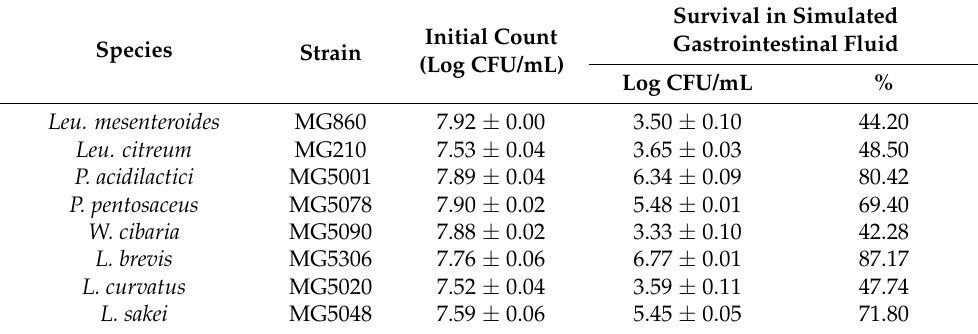
Table 2. Survival rate of the LAB strains in simulated gastrointestinal fluid.